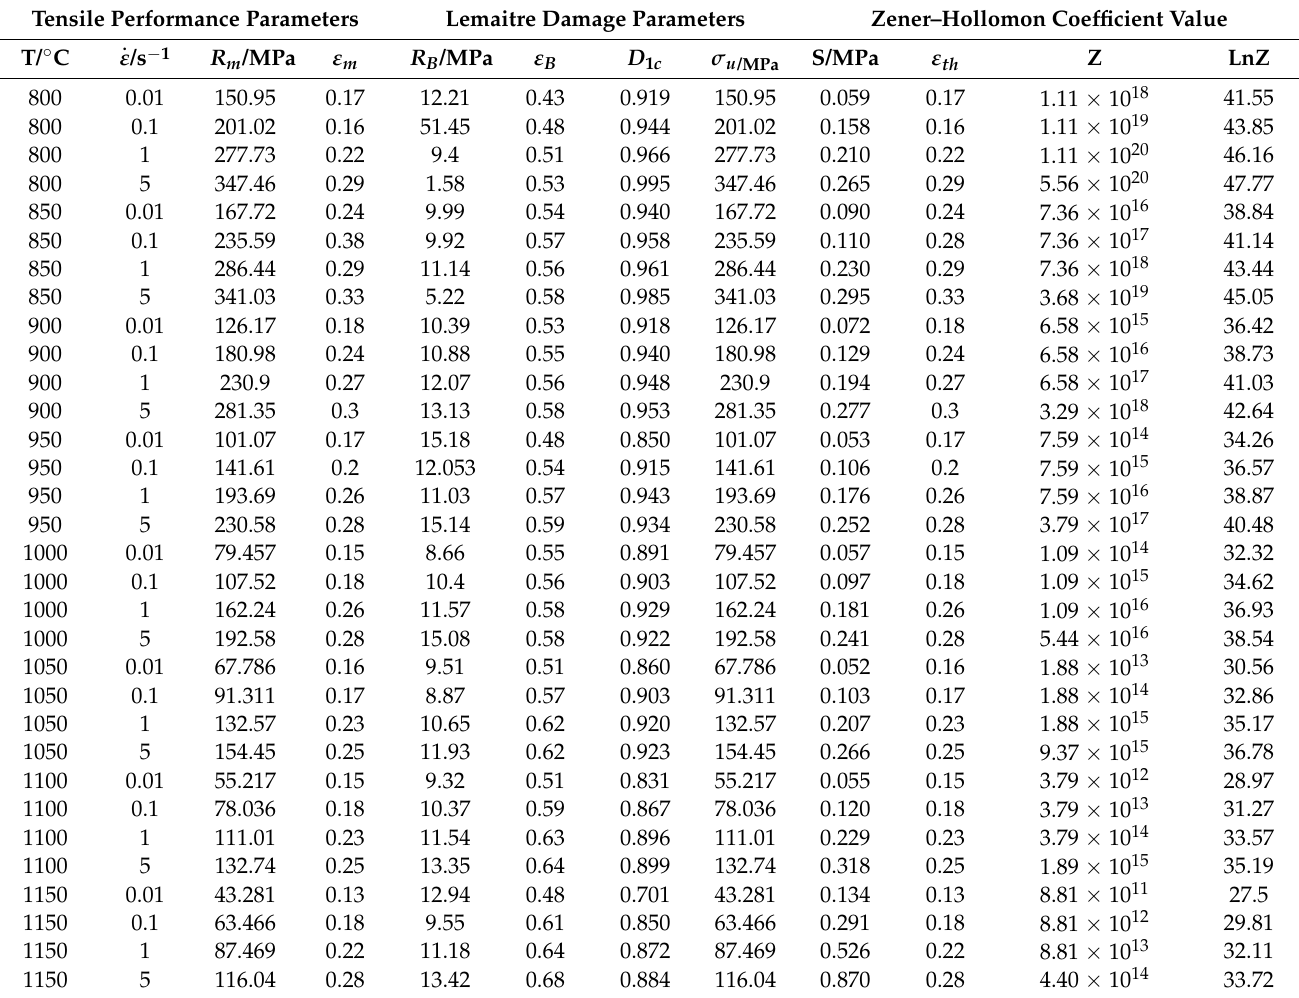
Table 4. Tensile properties, Lemaitre damage parameters and Zener–Hollomon coefficient of Cr5 steel at different temperatures and different strain